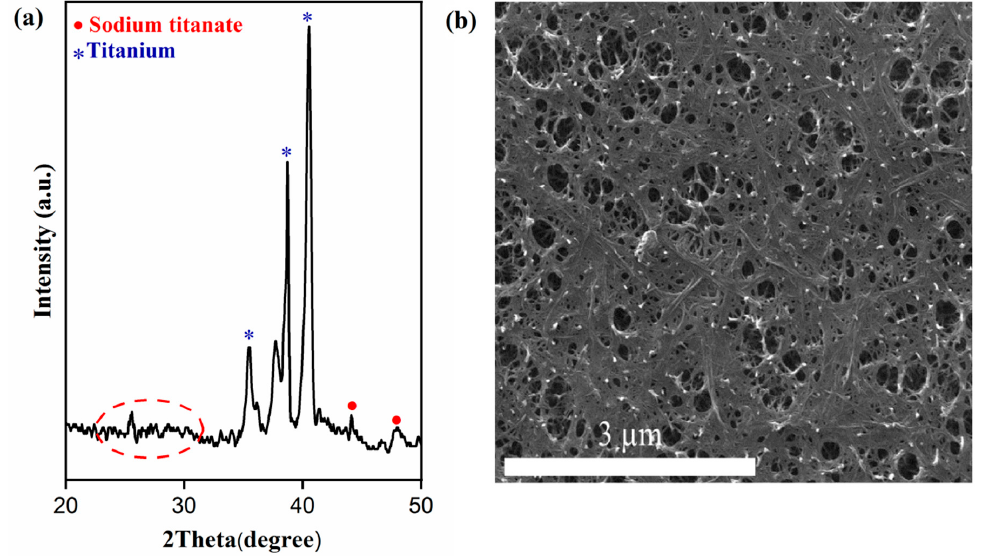
Figure 1. ( a ) XRD pattern and ( b ) SEM image of Ti6Al4V substrates after alkali-treatment